Question: What direction does the quantity move in — increasing or decreasing?
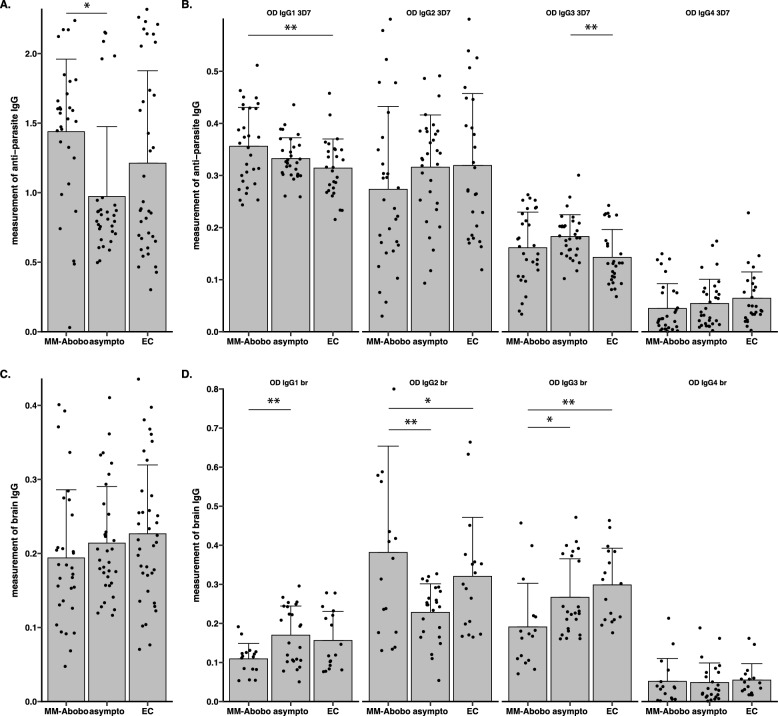
Answer: increasing